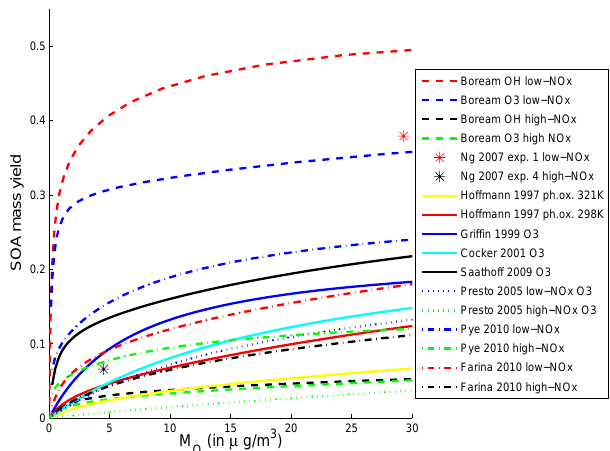
Fig. 12. Comparison of previously derived SOA mass yield curves from other studies, based on smog chamber experiments, with pa- rameterisations based on the BOREAM model (four scenarios, dashed lines). Also shown are the measured experimental yields of experiments 1 and 4 in Ng et al.